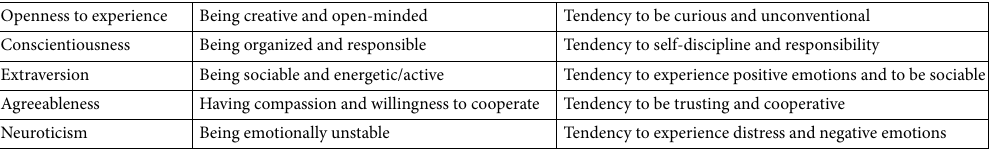
Table 1. The Table of definitions of the five personality traits.